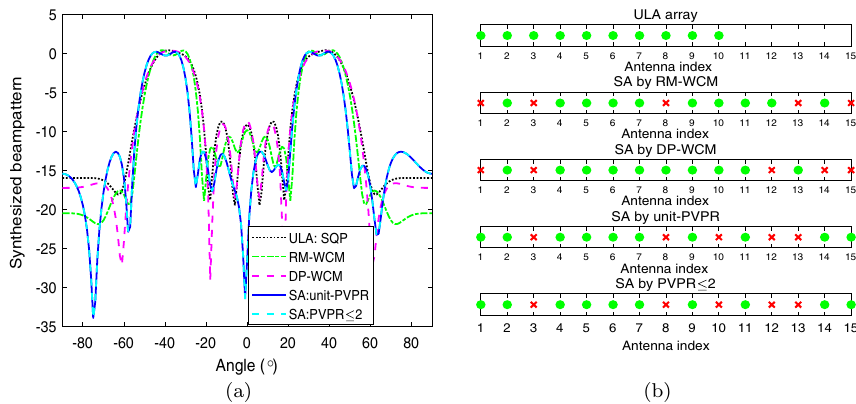
Fig. 7 a Synthesized wide-mainlobe beampatterns with different methods; b Antenna locations, where red crosses denote the discarded antennas and green solid circles the selected